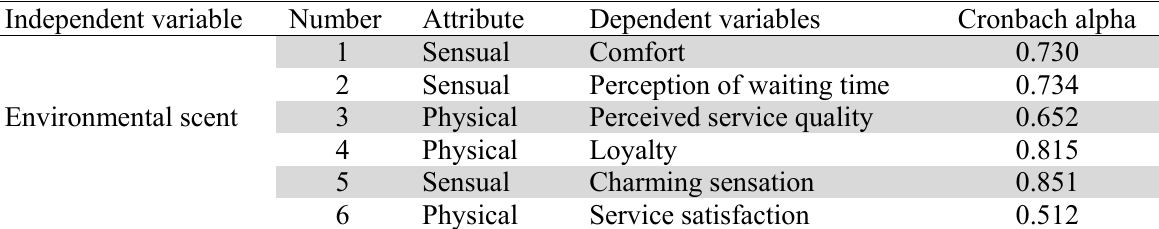
Indices and variables of research Independent